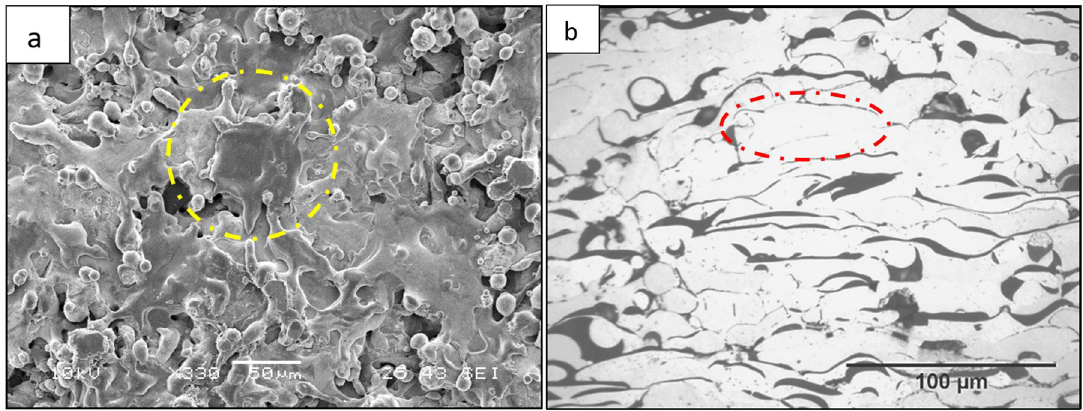
Figure 2. Microstructure of the Bond Coat. a) surface morphology in which an individual splat is shown within the yellow circle, b) cross section morphology in which an individual lamella is shown within the red